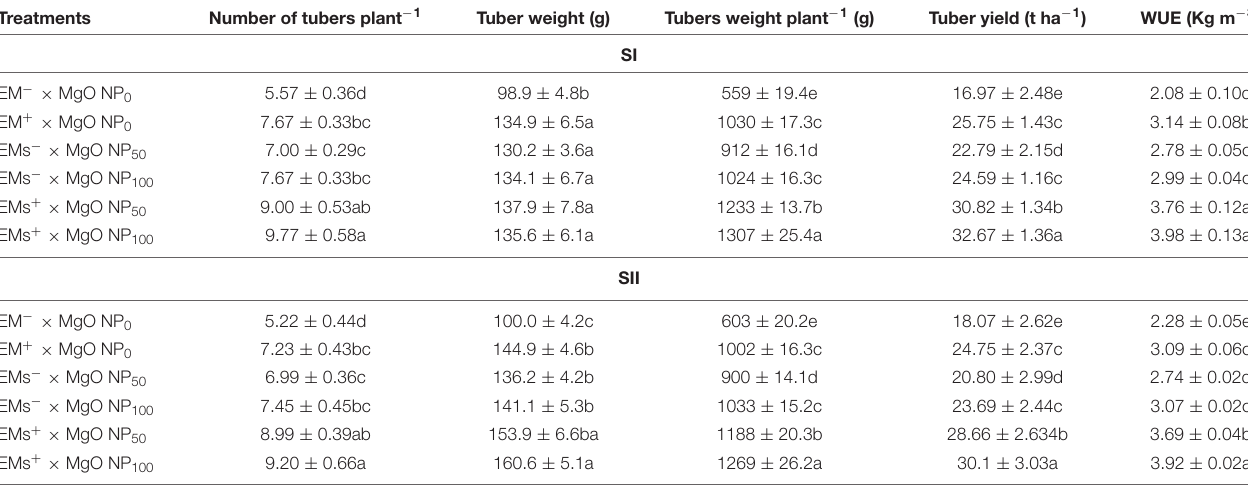
TABLE 3 | Effect of foliar application with magnesium oxide (MgO) nanoparticles (MgO-NP) and effective microorganisms (EMs) on yield and yield components and water use efficiency (WUE) of sweet potato ( Ipomoea batatas L.) grown in salt affected soil in 2020 (SI) and 2021 (SII) seasons.